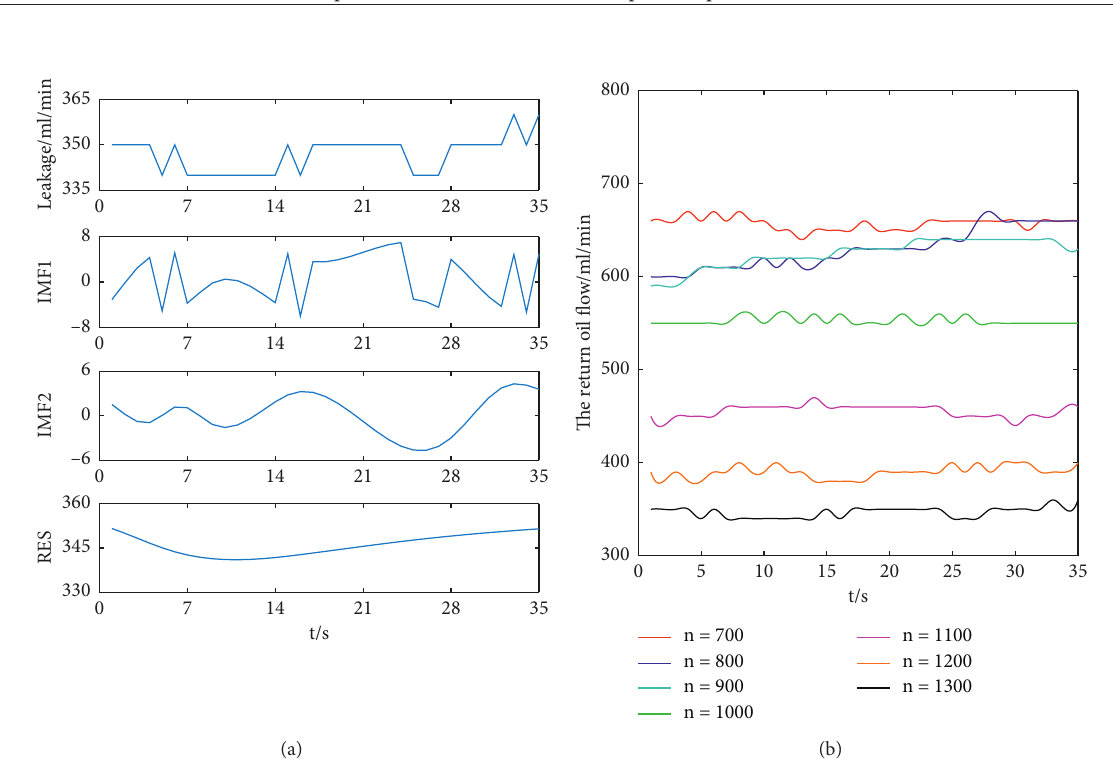
Figure 16: The data acquisition diagram of the return oil flow rate. (a) The return oil flow rate data EMD results under p � 20MPa n � 1300 r/min; (b) the return oil flow rate under different working